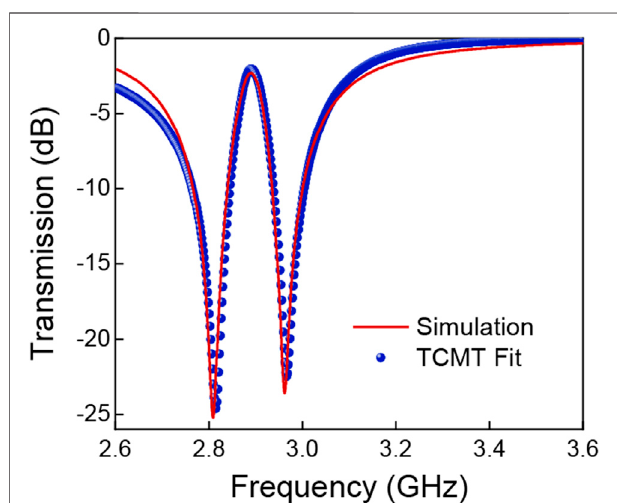
FIGURE 4 | Transmission spectra of the metasurface predicted by the TCMT (blue points) and simulated through FDTD (red curve) with the capacitance 2.63